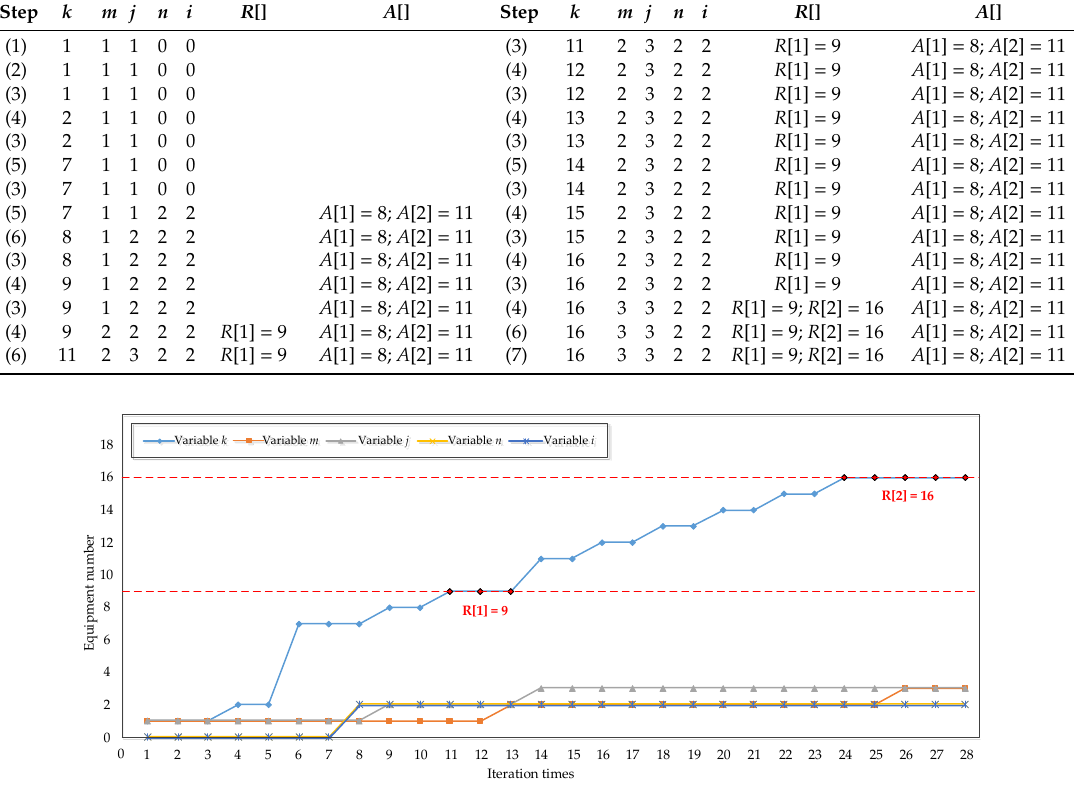
Table 5. The operation steps of test case 2.